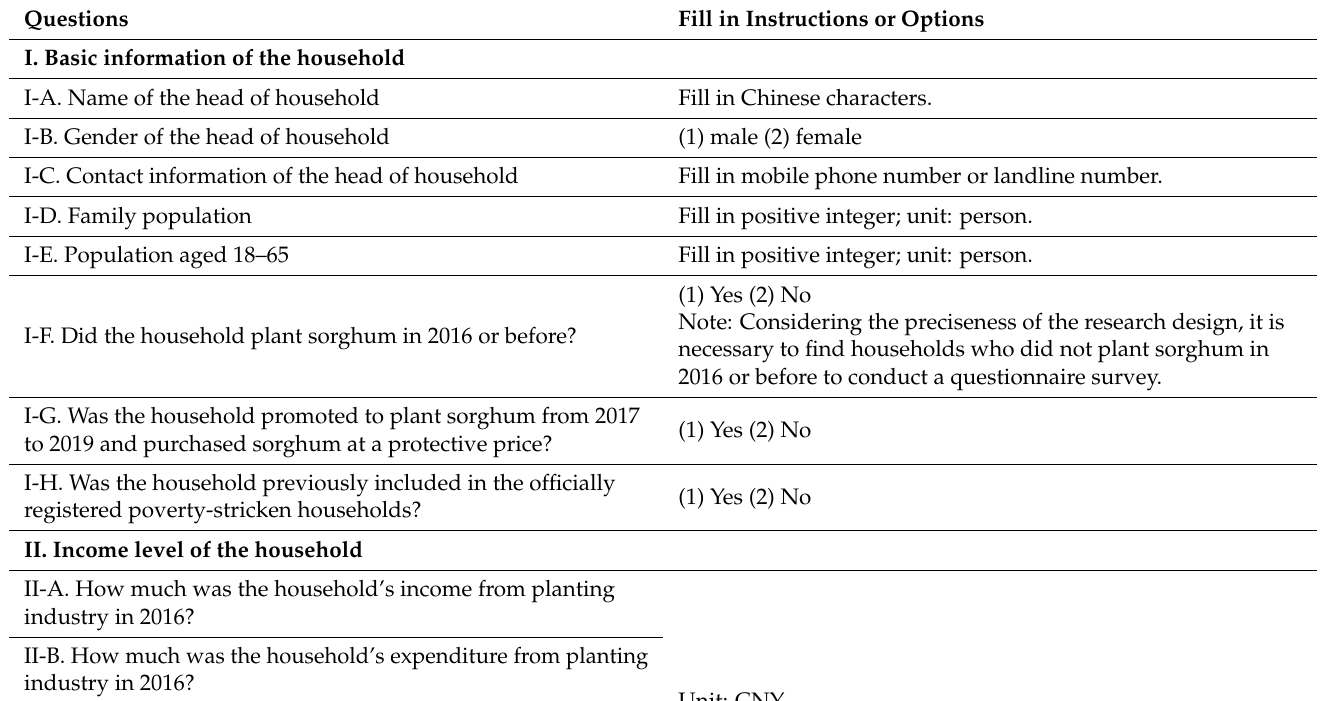
Table A2. Sample of questionnaire of Tanglang Village Committee in Tanglang Township and Dache Village Committee in Zehei